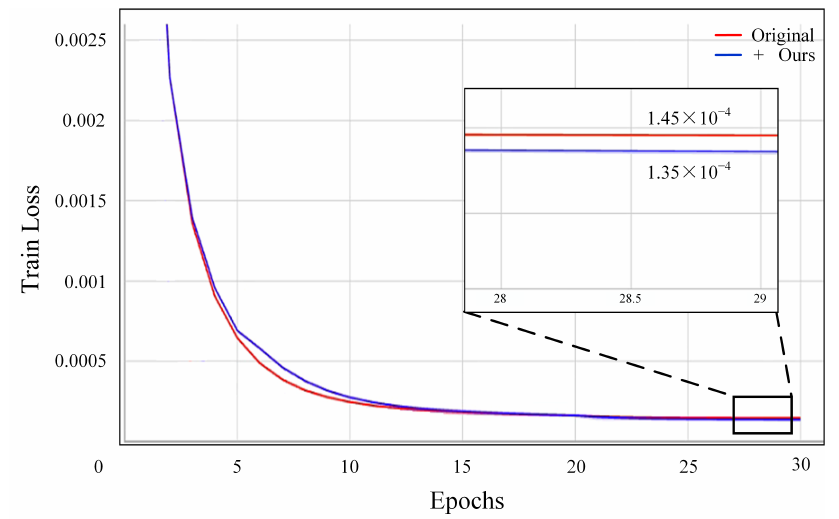
Figure 18. Convergence comparison of the network’s training loss curve (red) without DA and the training loss curve (blue) when using our proposed DA method. Our entire experimental setup was the same as that in Section